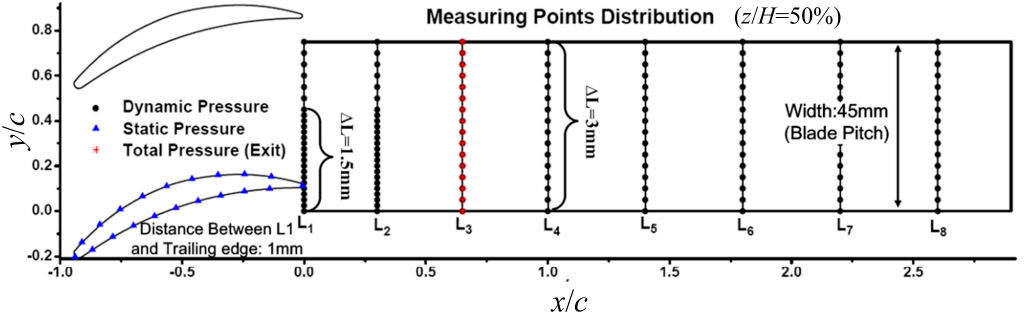
Figure 19. Schematic diagram of locations of measuring points in the cascade.